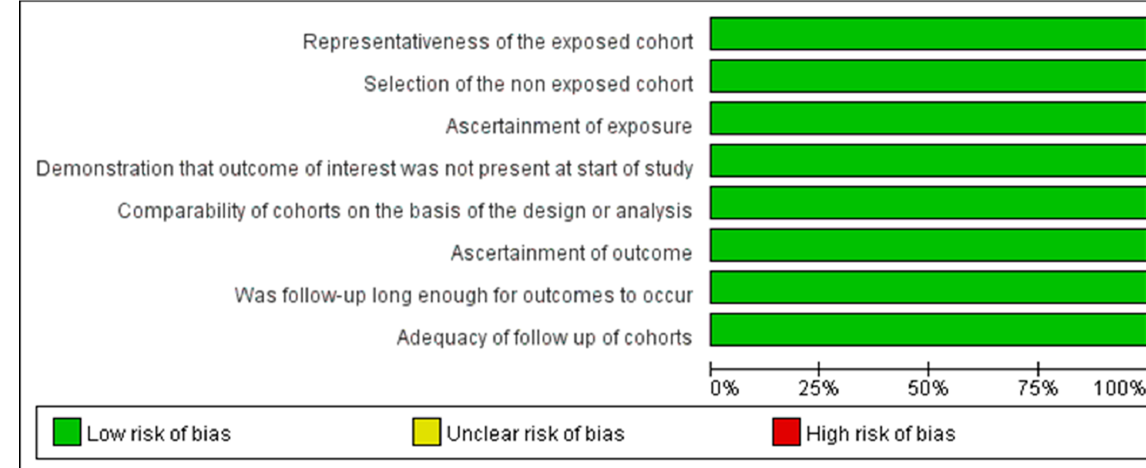
Figure 3. Quality assessment of the included cohort studies.